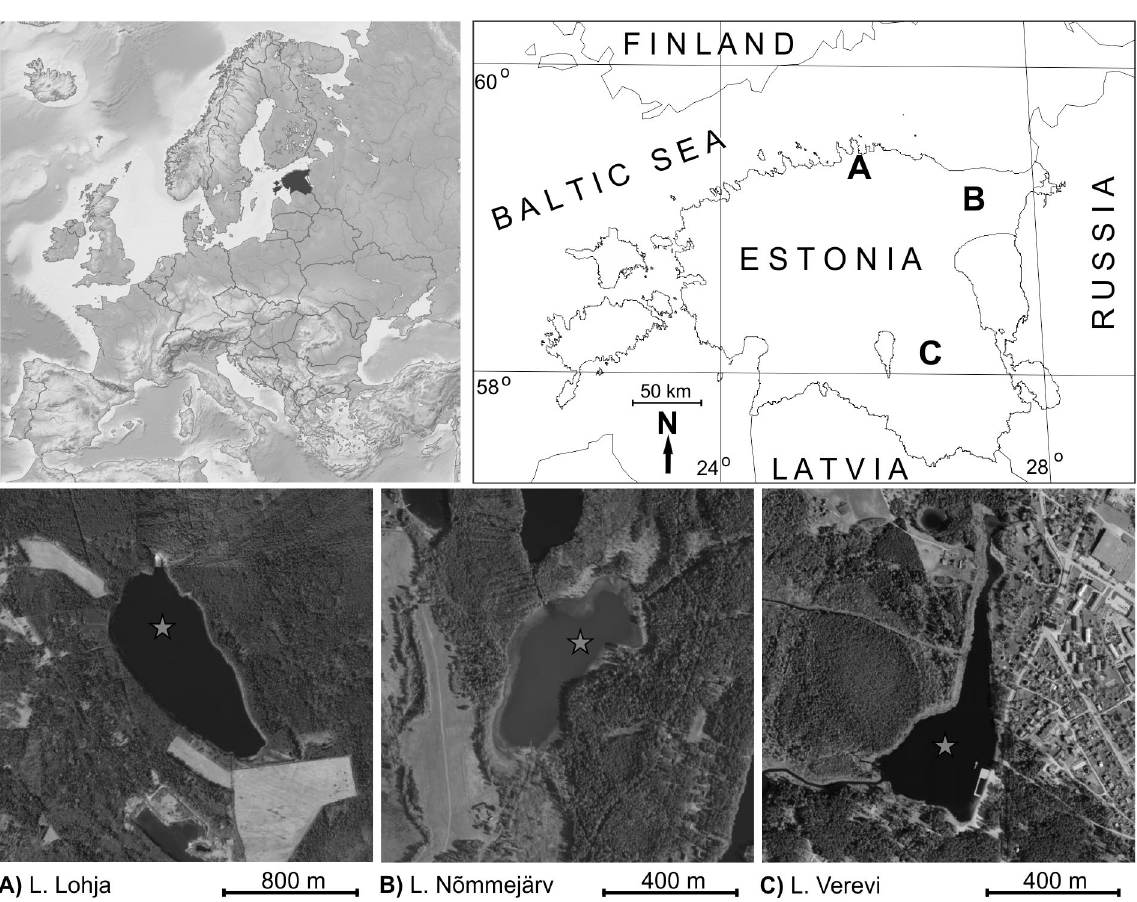
Fig. 1. Regional location of Estonia (top left). Location of the study sites (top right): A , Lake Lohja; B , Lake Nõmmejärv; C , Lake Verevi and aerial photos of the studied lakes and coring